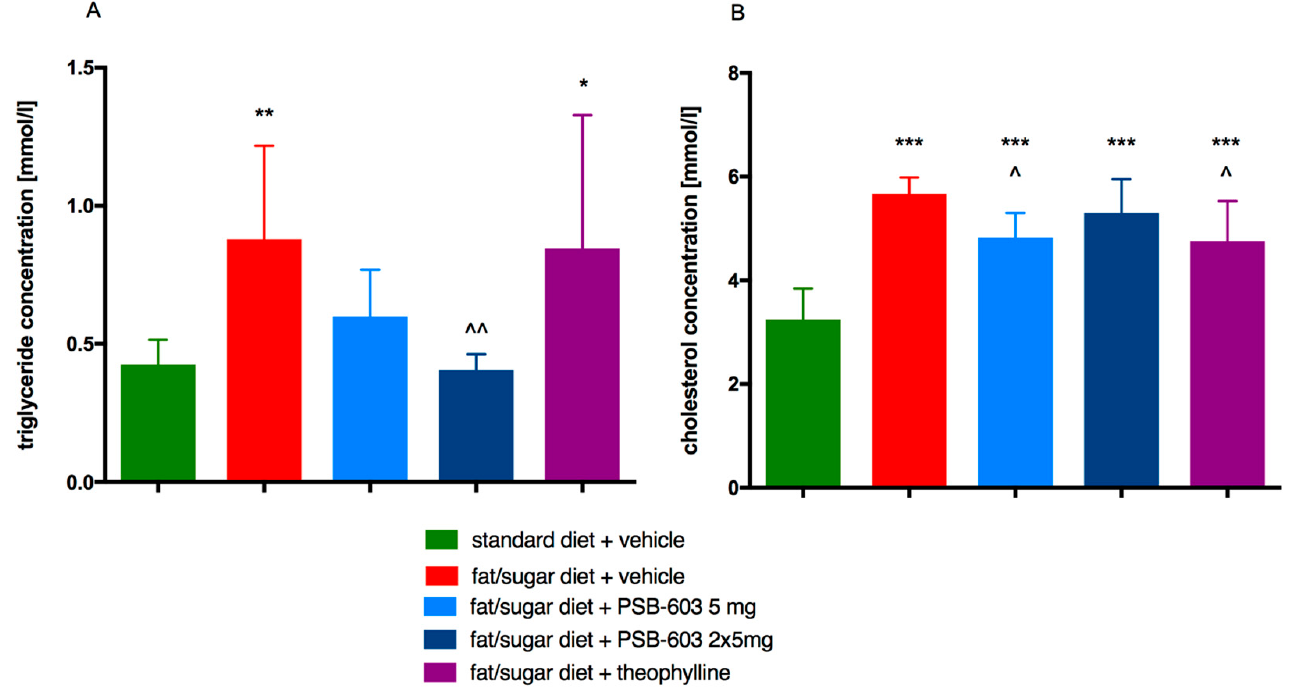
Figure 8. Effect of PSB-603 or theophylline administration on plasma levels of triglycerides ( A ) or total cholesterol ( B ). Results are expressed as means ± SD, n = 9–10. Comparisons were performed by one-way ANOVA Tukey post hoc; * Significant compared to control mice fed a standard diet; ˆ Significant compared to control mice fed fat/sugar diet; *, ˆ p < 0.05, **, ˆˆ p < 0.01, *** p < 0.001. Total cholesterol levels in all obese groups were higher than in the standard-feed control group. There were no significant differences in total plasma cholesterol levels between the obese control group and the PSB-603 treated group at a dose of 2 × 5 mg/kg b.w./day. In contrast, total cholesterol was significantly lower in the groups treated with PSB-603 at a dose of 5 mg/kg b.w. or with theophylline compared to the control group fed high-fat feed (F(4,44) = 23.28, p < 0.0001) (Figure